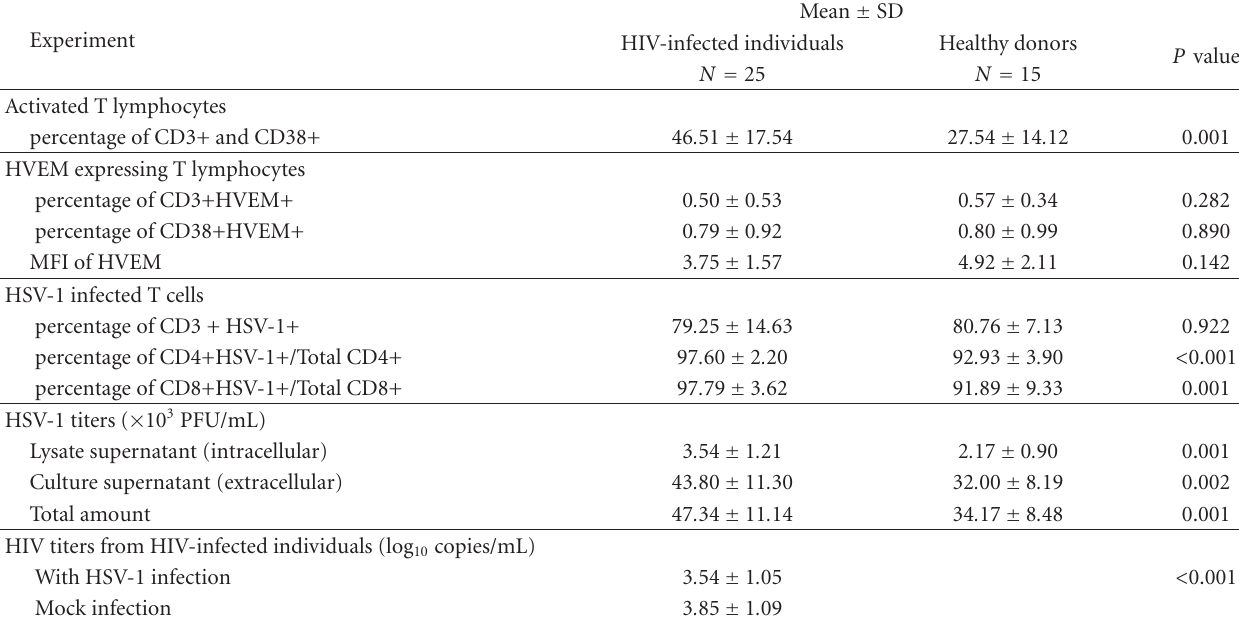
Table 1: Characteristics of PBMCs from HIV-infected individuals and healthy